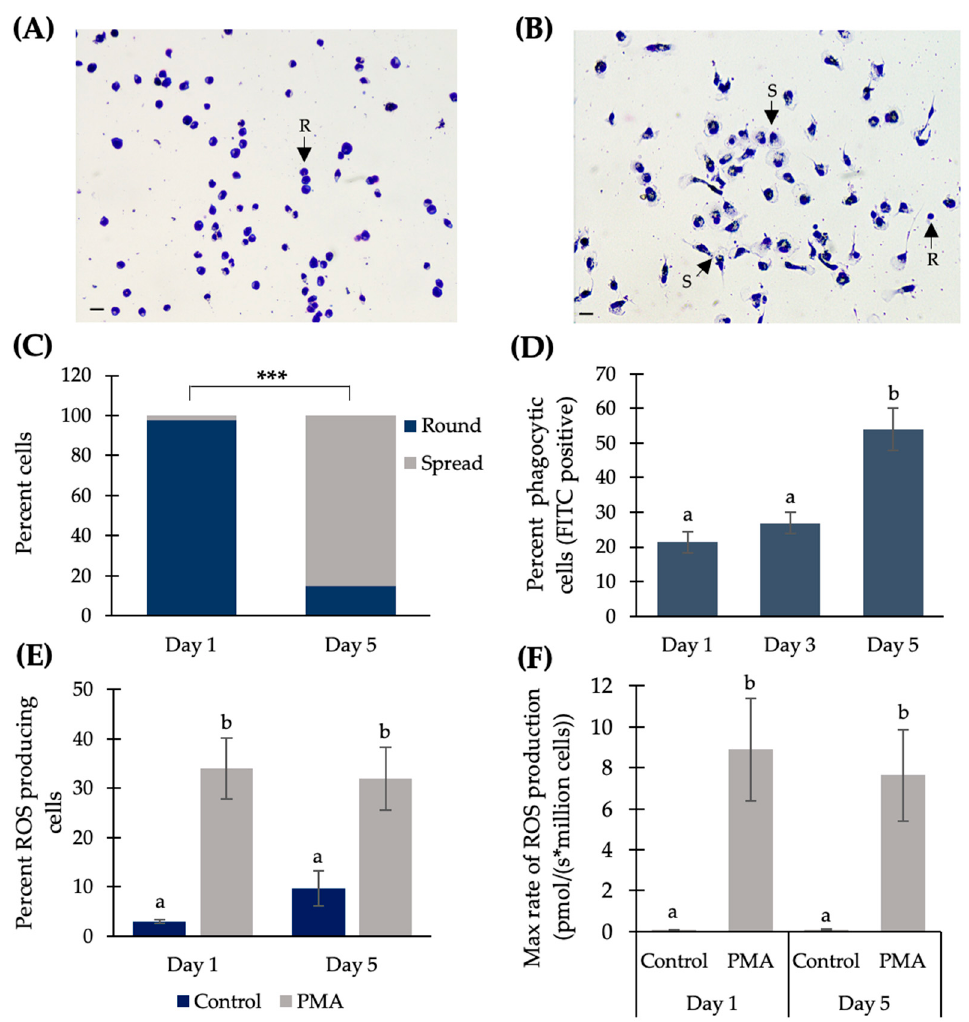
Figure 1. Influence of culture time on the morphology and function of Atlantic salmon adherent head kidney leukocytes (HKLs). Representative images of Giemsa-stained HKLs cultured for ( A ) 1 day and ( B ) 5 days. Arrows indicate spread cells (S; cells with pseudopodia present) and non-spread, round cells (R; cells with no pseudopodia present). Scale bar on the bottom left of panel ( A ) and panel ( B ) is equal to 20 µ m. ( C ) Mean percentage of round vs. spread cells in Day 1 and Day 5 cultures, where *** indicates a significant di ff erence of p < 0.0001 by chi-square test. ( D ) Percentage of phagocytic HKLs on Day 1 and Day 5 of culture. ( E ) Percentage of HKLs producing reactive oxygen species (ROS), as determined by flow cytometry. ( F ) Maximum rate of ROS production (pmol / (s*million cells)), as determined by Oroboros respirometry. Day 1 control value: 0.089 pmol / (s*million cells); Day 5 control value: 0.105 pmol / (s*million cells). Data shown as the mean +/ − SE; di ff erent lowercase letters indicate a significant di ff erence of p < 0.05 as determined by a repeated measures one-way ANOVA for phagocytosis data and a paired Student’s T -test for ROS data, n = 4. PMA: phorbol myristate acetate. To determine how the phagocytic ability of HKLs changes from Day 1 to Day 5 of culture, cells were incubated with fluorescent (FITC) beads and, 24 h later, FITC fluorescence was analyzed via flow cytometry. On Day 1, 21.4 ± 3.1% (SE) of the cells were phagocytic; on Day 3, 26.9 ± 2.9% of the cells were phagocytic; and on Day 5, 53.9 ± 6.1% of the cells were phagocytic (Figure 1D). There was